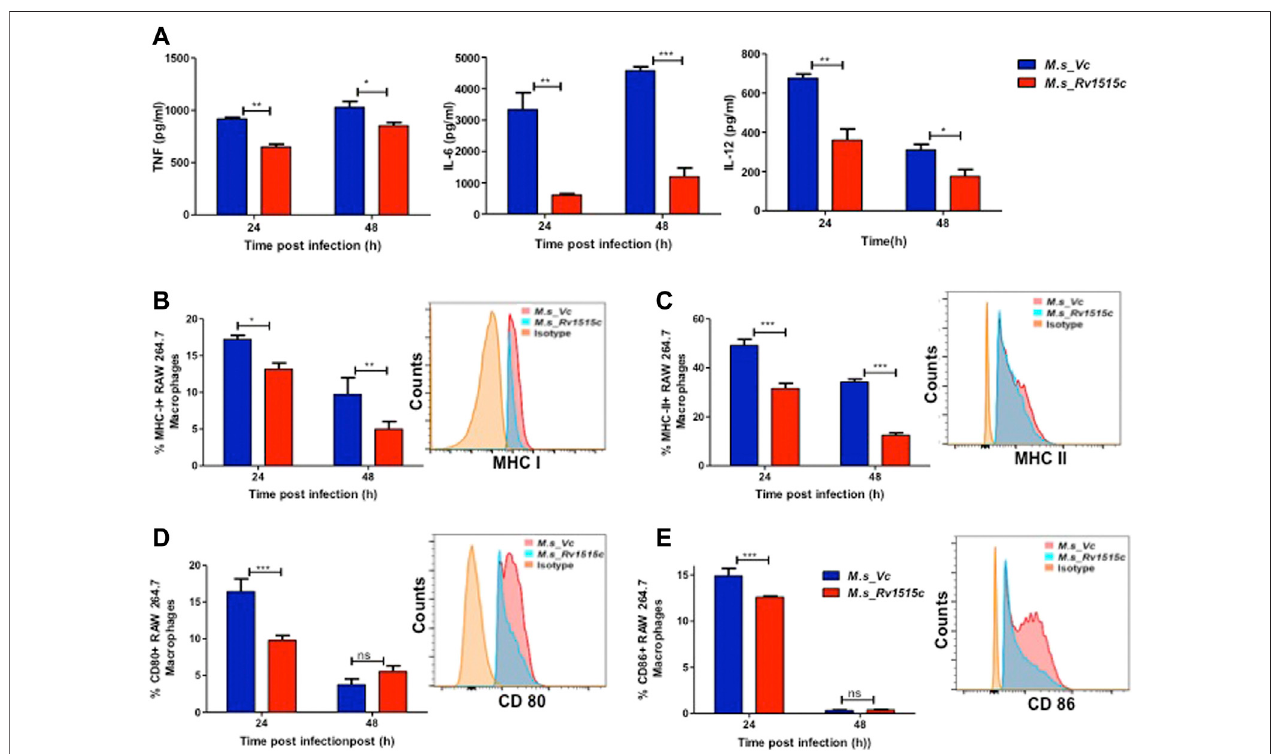
FIGURE 6 | Recombinant M. smegmatis expressing M. tb Rv1515c suppress pro-in fl ammatory cytokine and molecules involved in antigen presentation. RAW 264.7cellswereincubatedwithequalnumberof M.s _Vcand M.s _Rv1515ccellsataMOIof1:10for24,48 h. (A) TheculturesupernatantwascollectedandELISAwas done to assess the levels of cytokines: TNF- α , IL-6, and IL-12. Percent cells expressing (B) MHC I, (C) MHC II, (D) CD80, (E) CD86 in the culture were analysed fl ow cytometrically. Inset shows the representative histogram of fl ow cytometry at 24 h. Data are represented as mean ± SD from three independent experiments, and statistical analysis was performed using two-way ANOVA followed by Bonferroni test. * p < 0.05, ** p < 0.01, *** p <